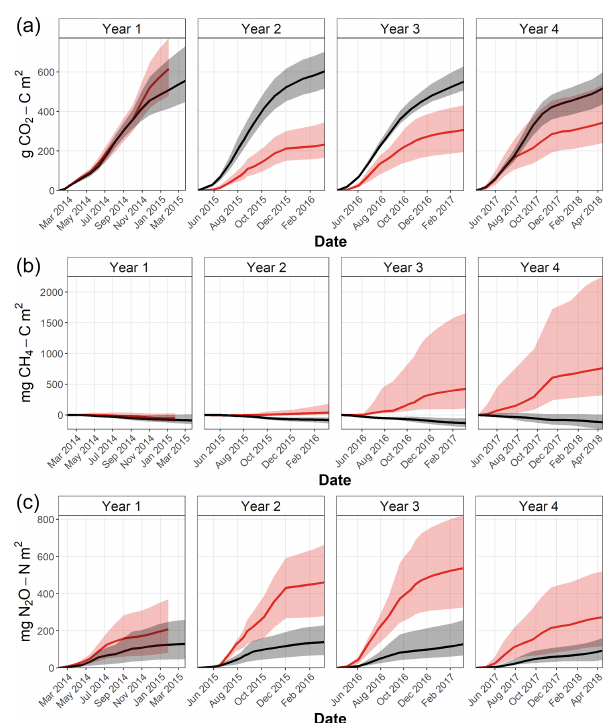
Figure 5. Cumulative soil fluxes of CO 2 (a) , CH 4 (b) , and N 2 O (c) in Harwood Forest from area A (black; mature spruce stand, remaining) and area B (red; mature spruce stand, clear- felled after year 1) during each year, calculated from median fluxes of eight replicated chambers. Ribbons are the estimated 95% con- fidence